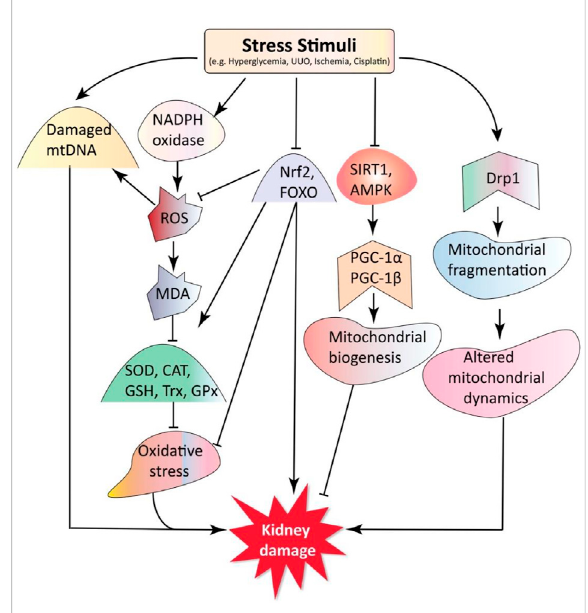
FIGURE 1 Mitochondria dysfunction in kidney diseases. Stress stimuli, such as hyperglycemia (HG), unilateral ureteric obstruction (UUO), cisplatin, and ischemia cause an imbalance between oxidative stressandantioxidants.Understressstimuli,theexpressionof transcription factors nuclear factor erythroid 2-related factor 2 ( Nrf-2 ) and forkhead box O (FOXO) decreases, activating nicotinamide adenine dinucleotide phosphate (NADPH) oxidase leading to excessive ROS and malondialdehyde (MDA)production. This oxidative stress also reduces the transcription of antioxidants such as superoxide dismutase ( SOD ), catalase ( CAT ), glutathione synthetase ( GSS ), glutathione peroxidase ( GPX ), and thioredoxin ( Trx ).Sirtuin1(SIRT1)andAMP-activatedproteinkinase(AMPK)can activate peroxisome proliferator-activated receptor γ coactivator 1 α (PGC-1 α ), a master regulator of mitochondrial biogenesis. The activated dynamin-related protein 1 (Drp1) disturbs mitochondrial dynamics and causes mitochondria fragmentation. Moreover, various stress stimuli can induce mtDNA damage. Altogether, these cause changes in mitochondria structure and